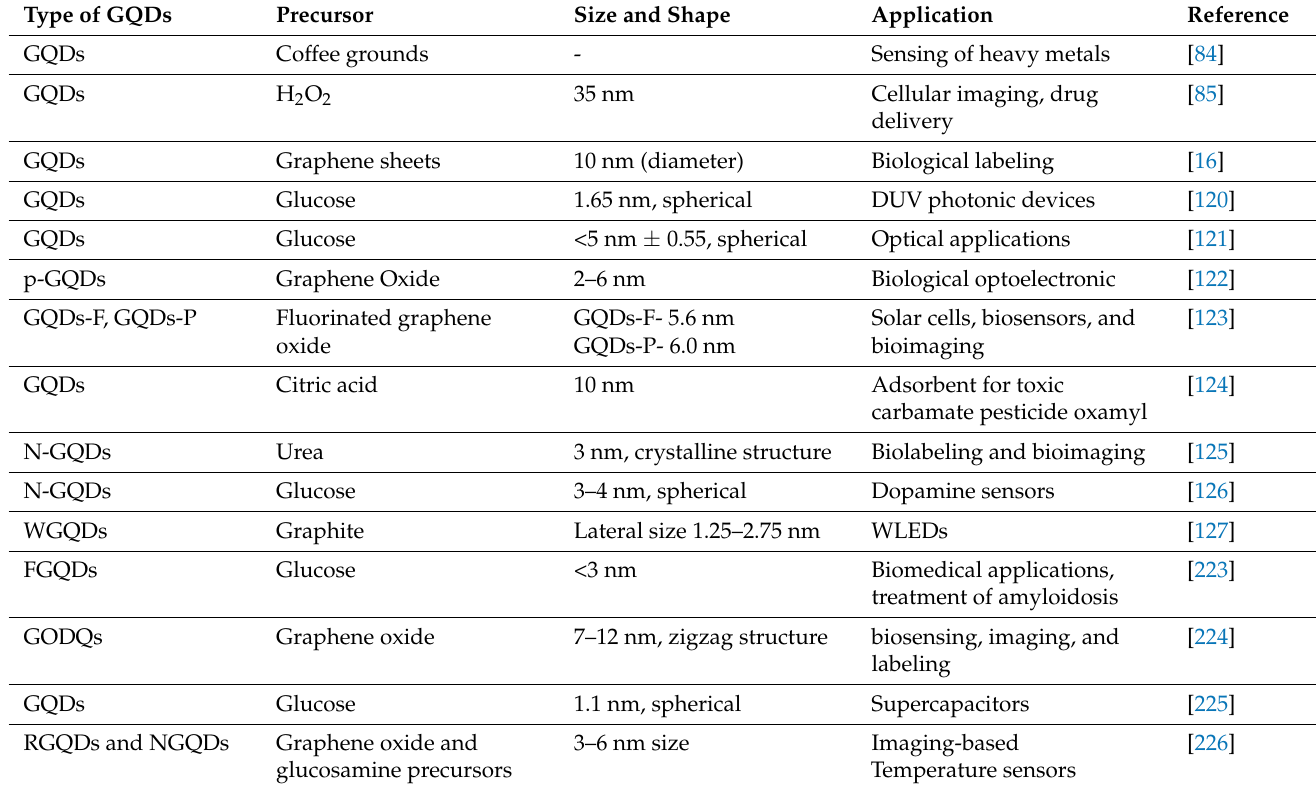
Table 4. The hydrothermal and microwave-assisted hydrothermal methods for the preparation of GQDs.